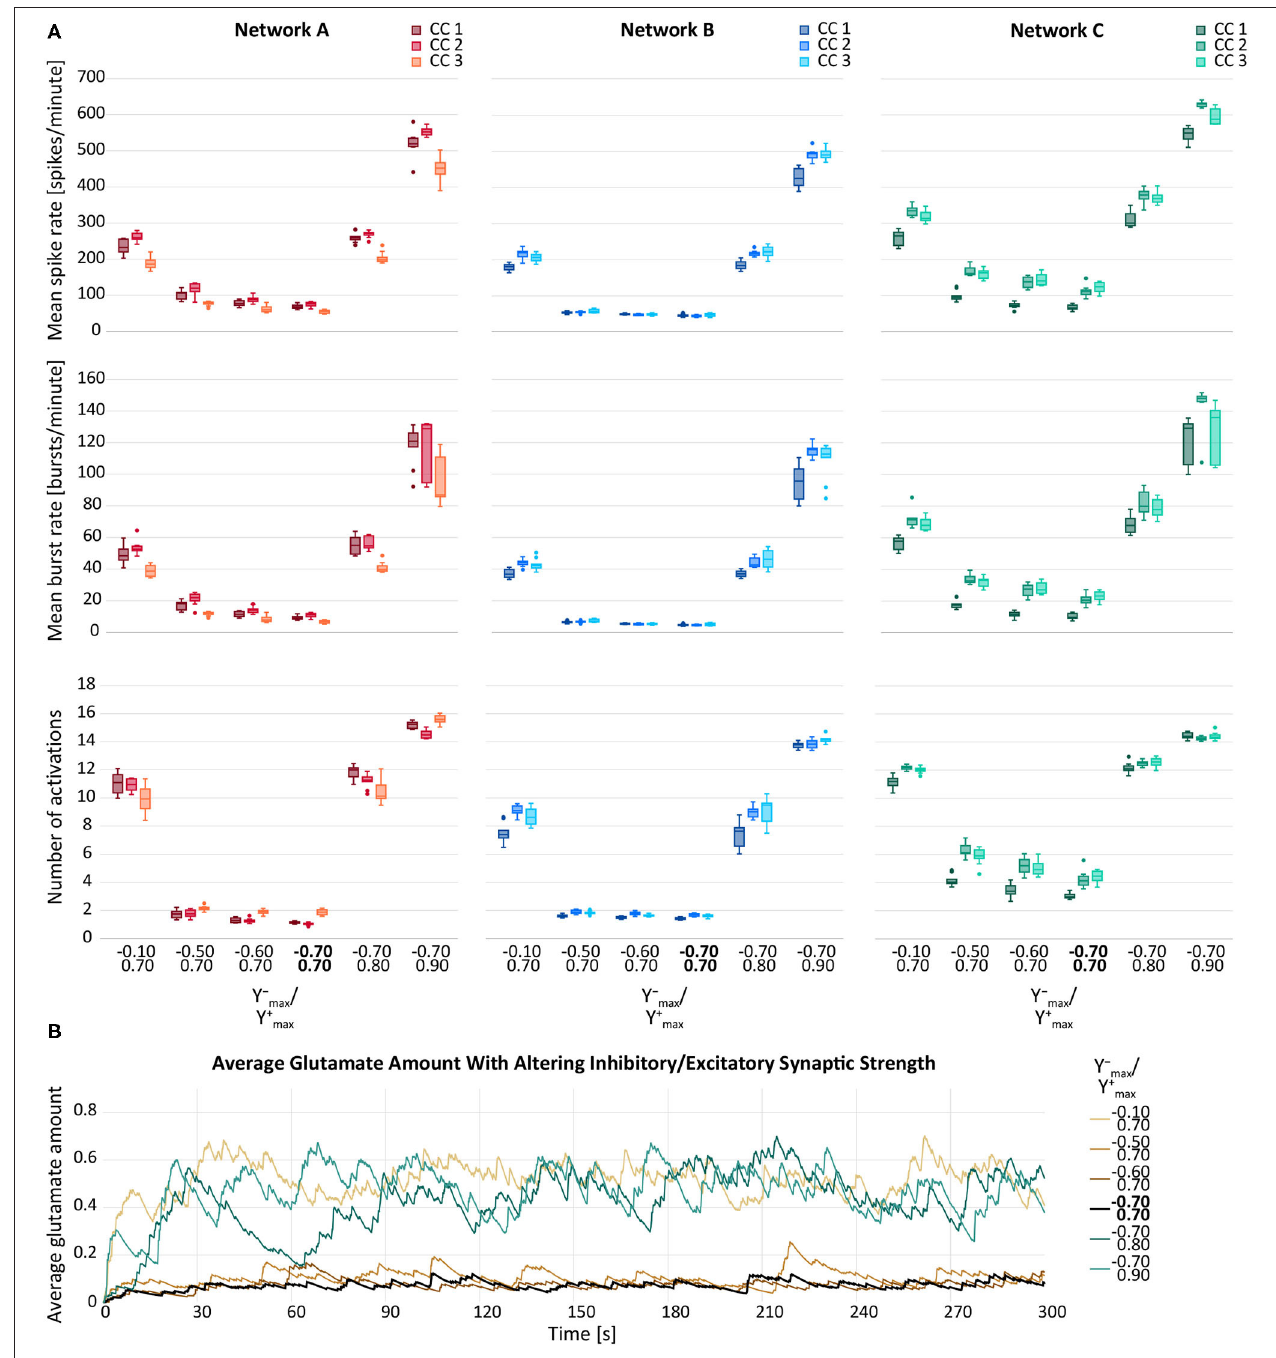
FIGURE 6 | (A) Mean spike rate (top), mean burst rate (middle) and mean number of activations per astrocyte (bottom) for varying maximum inhibitory ( Y − max ) and maximum excitatory synaptic weight ( Y + max ) of neurons for networks A–C and their connectivity configurations CC 1 , 2 , 3 . The default values are indicated in bold. (B) Average glutamate amount in astrocytes when altering the inhibitory and excitatory synaptic weights. The black line resembled the activity from the default network B, CC 1 . The brown lines represent the changes of Y − max and the blue lines the changes in Y + max .